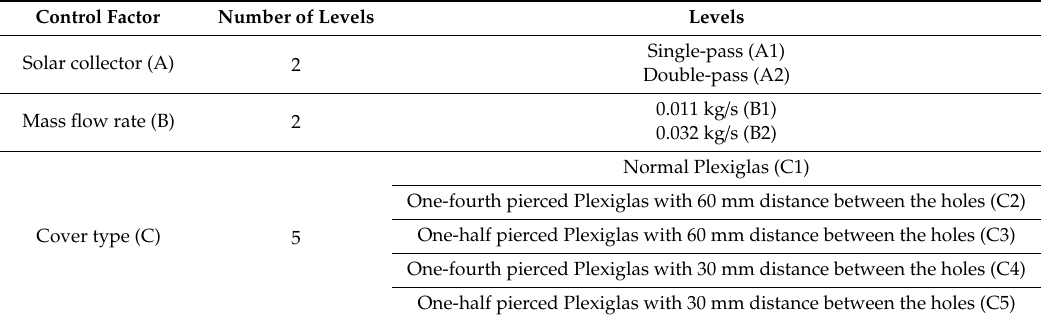
Table 1. The levels of control factors considered in the design of the solar air